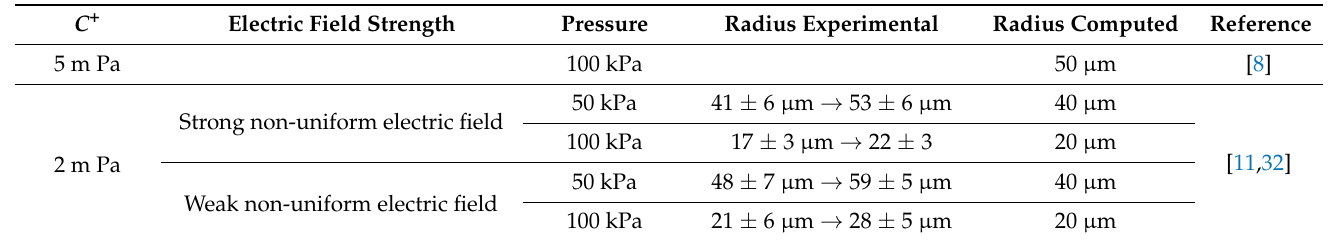
Table A5. Summary of Experimental Radii Corresponding to Different Proportionality Factors in SF 6 at 50 and 100